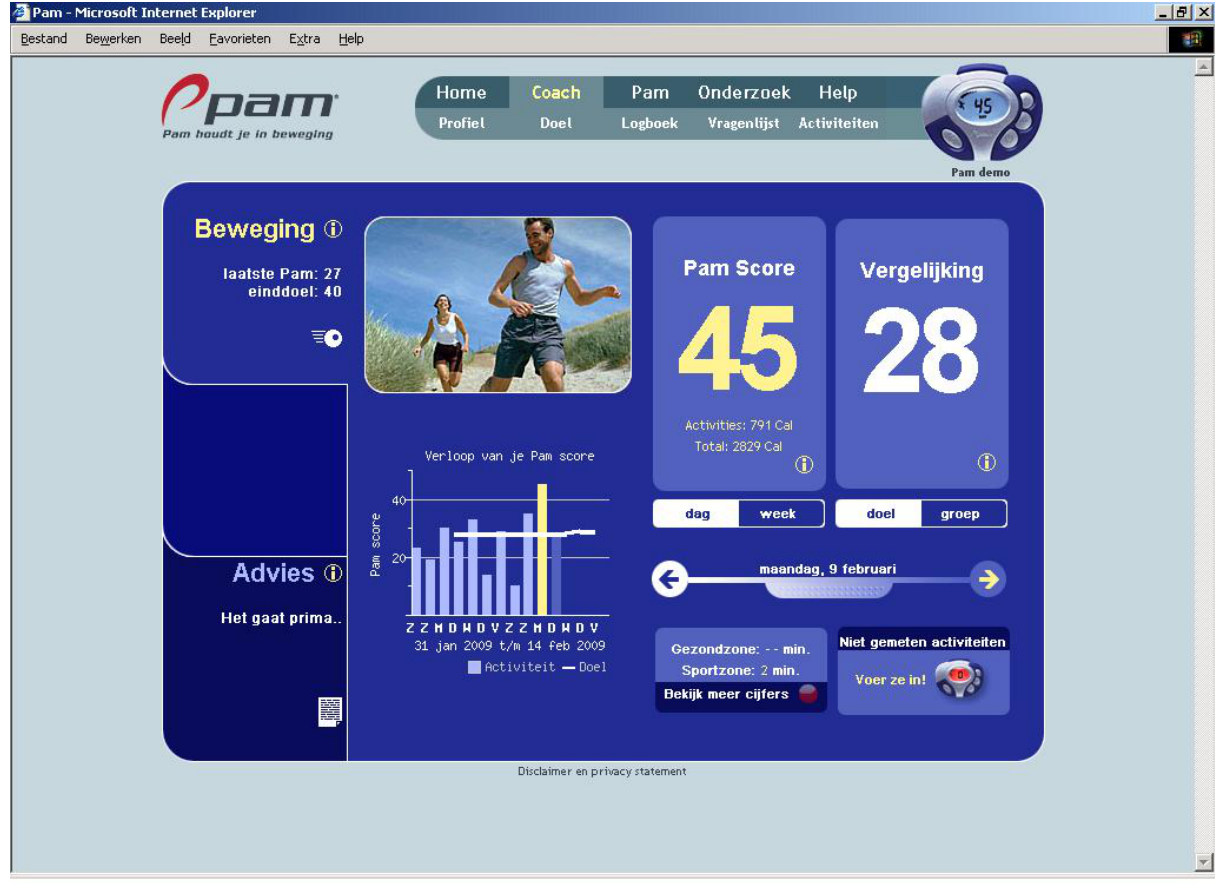
Figure 3. Screenshot of the PAM COACH